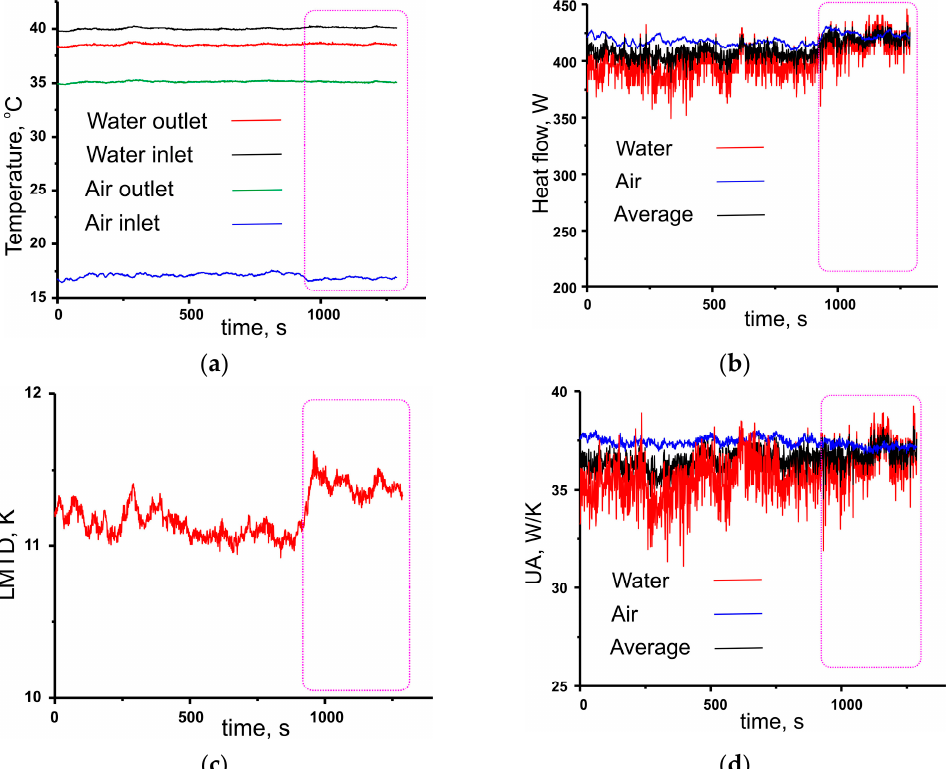
Figure 4. Typical temporal evolution of: ( a ) Inlet and outlet temperature in water and air circuits; ( b ) Heat flow in water and air circuits and average value; ( c ) Logarithm Mean Temperature Difference; ( d ) Global heat transfer coefficient calculated for water and air circuits and average value. Radiator R3, air flow rate f(air) = 19.1 × 10 − 3 m 3 /s, water flow rate f(w) = 63.86 × 10 − 6 m 3 /s. Time interval when heat flows become stable is outlined in pink.